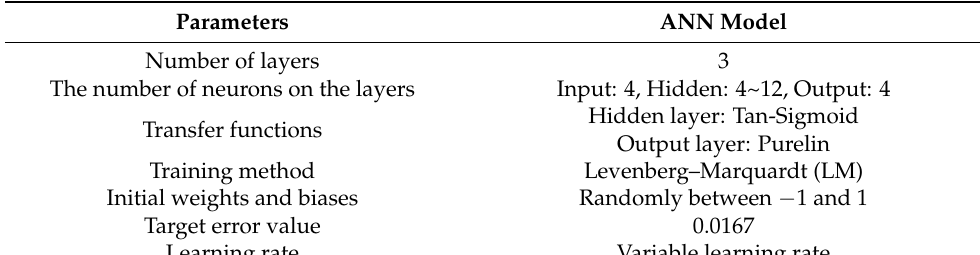
Table 2. The ANN model training parameters.